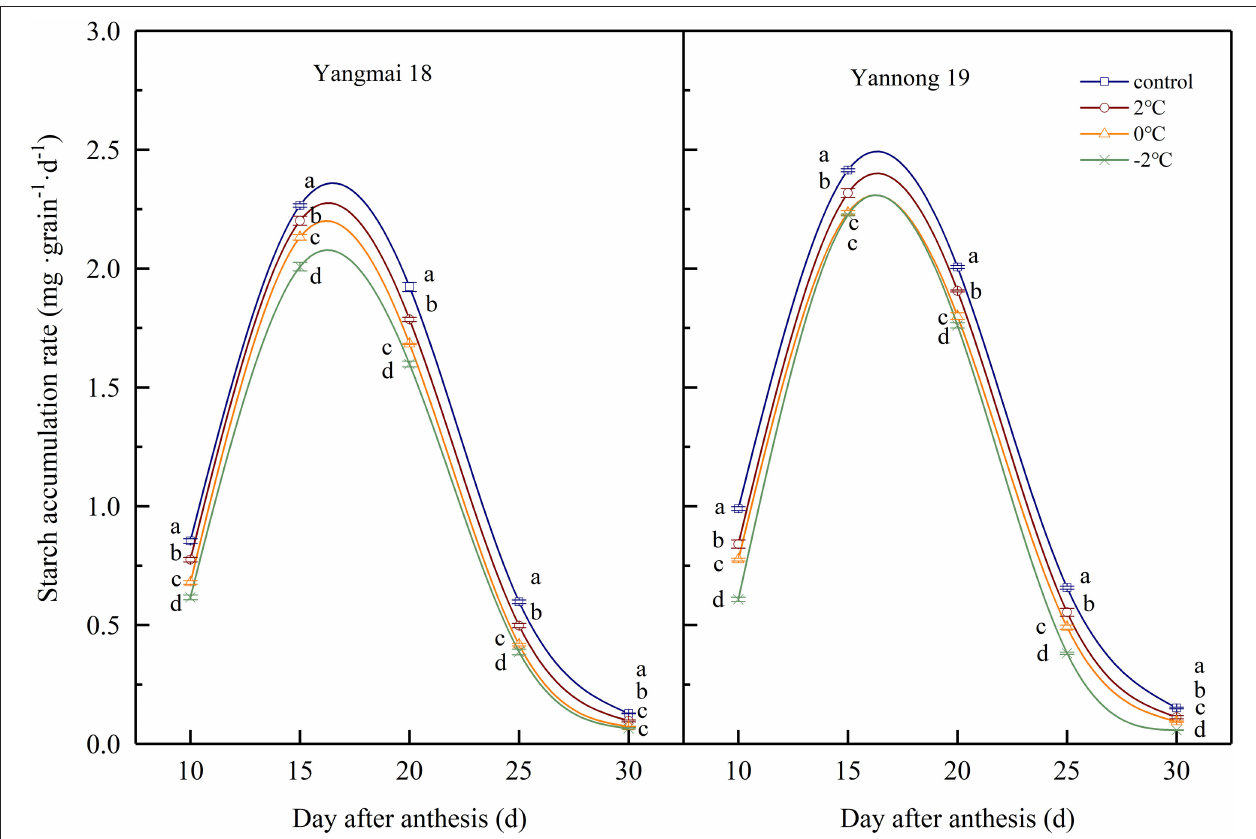
FIGURE 7 | The effect of short-term LT at the booting stage on the rate of starch accumulation. At the booting stage, wheat plants were placed in an artificial climate chamber for LT stress. The temperature was set to 5 ◦ C during 07:00–19:00 and 2, 0, and − 2 ◦ C during 19:00–07:00. The normal growing plants without cold stress were used as controls. The data are presented as the means ± SD ( n = 3). Different lowercase letters indicate significant differences between the treatments determined using the Duncan’s multiple range test ( P < 0.05).